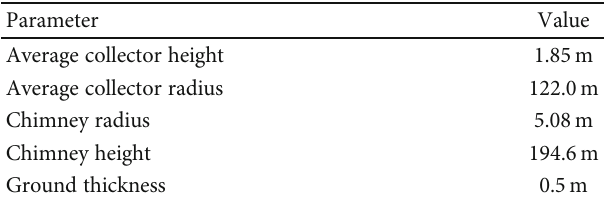
Table 1: Structural details of the pilot plant in Manzanares [28].